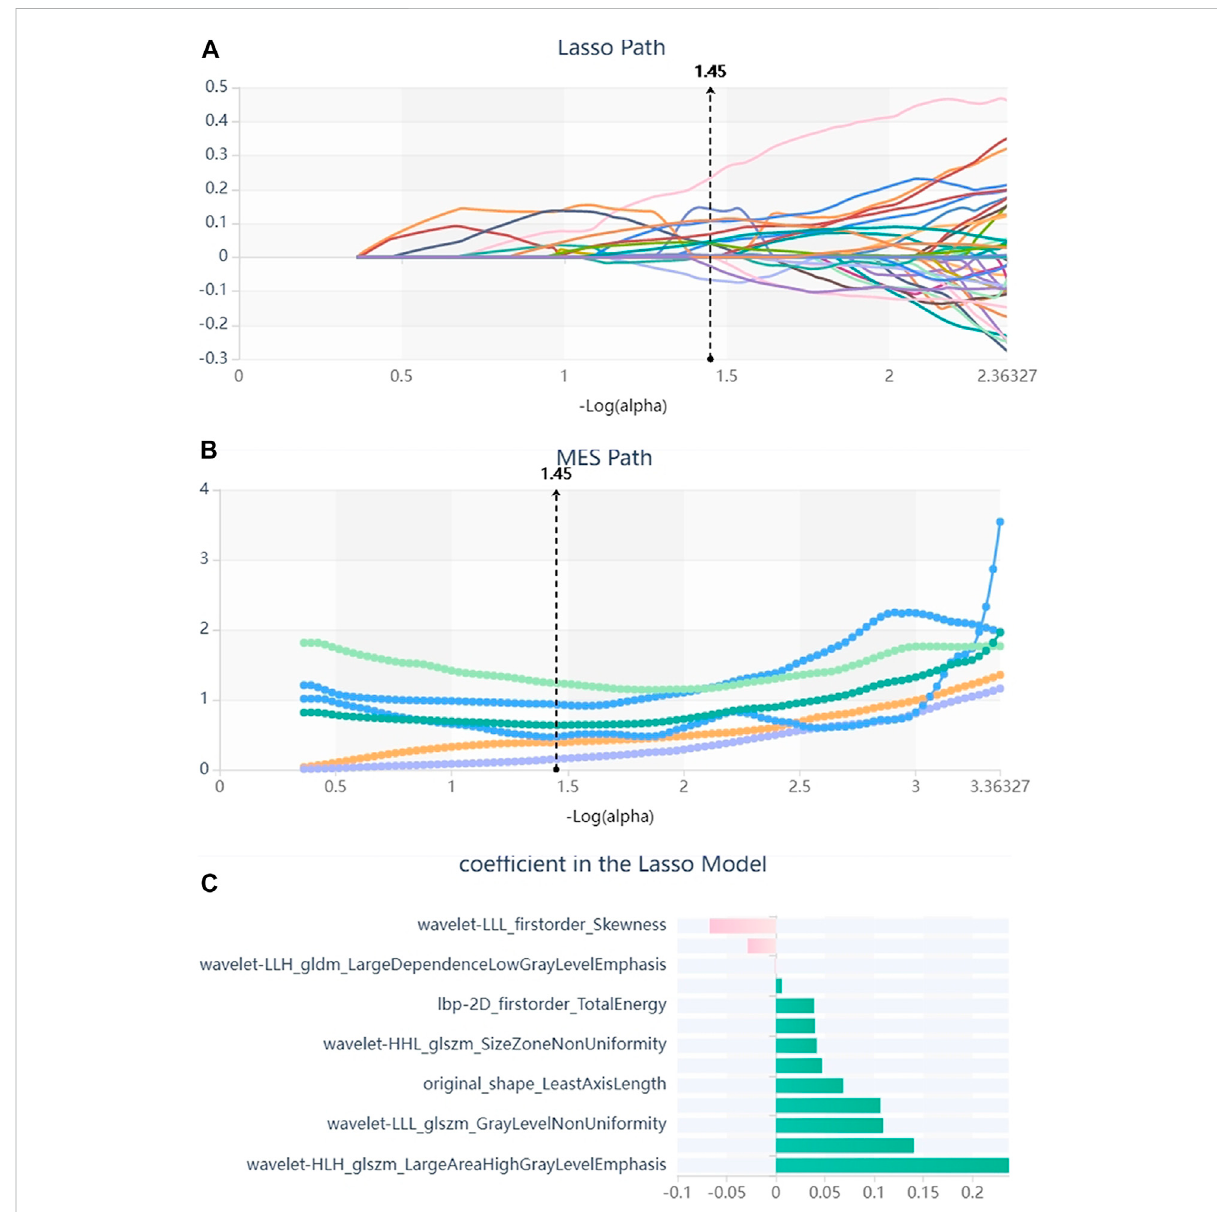
FIGURE 4 Lasso algorithm on feature selected. (A) Lasso path; (B) MSE path; (C) coef fi cients in Lass model. Using the Lasso model, 13 features that correspond to the optimal alpha value were